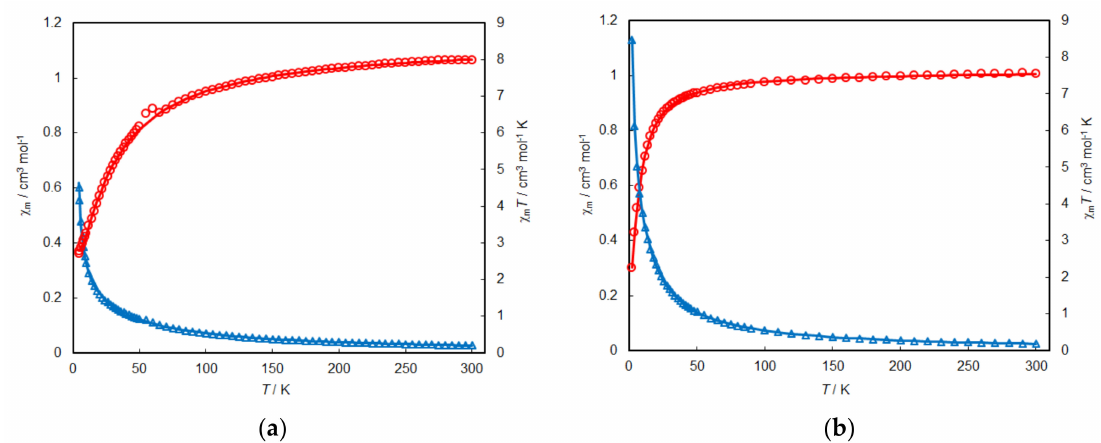
Figure 5. Temperature dependence of χ m (blue triangles) and χ m T (red circles) vs. T plots of 1 ( a ) and 2 ( b ). Solid lines are drawn with the best-fitted parameter values described in the text and in Table